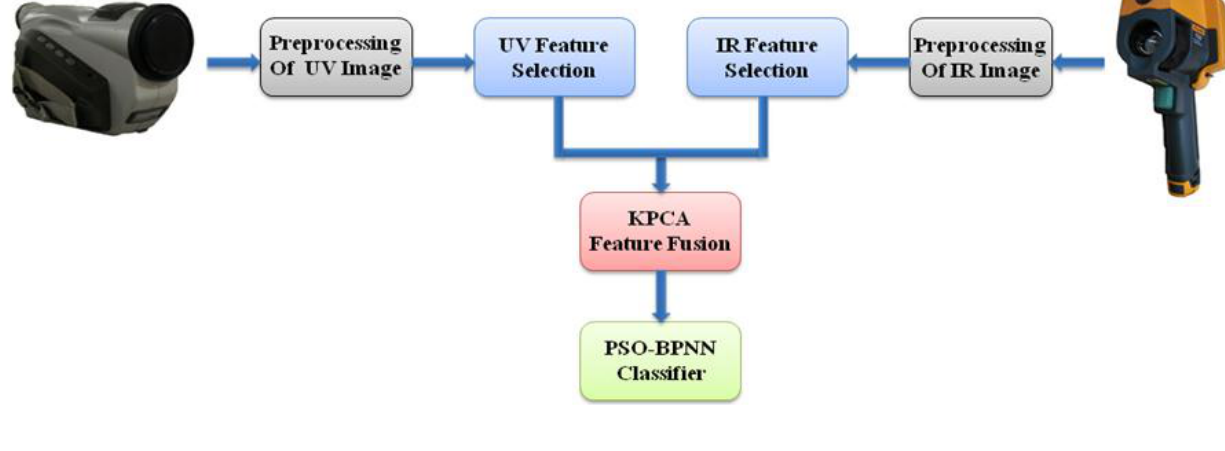
Figure 2. Flow chart of the